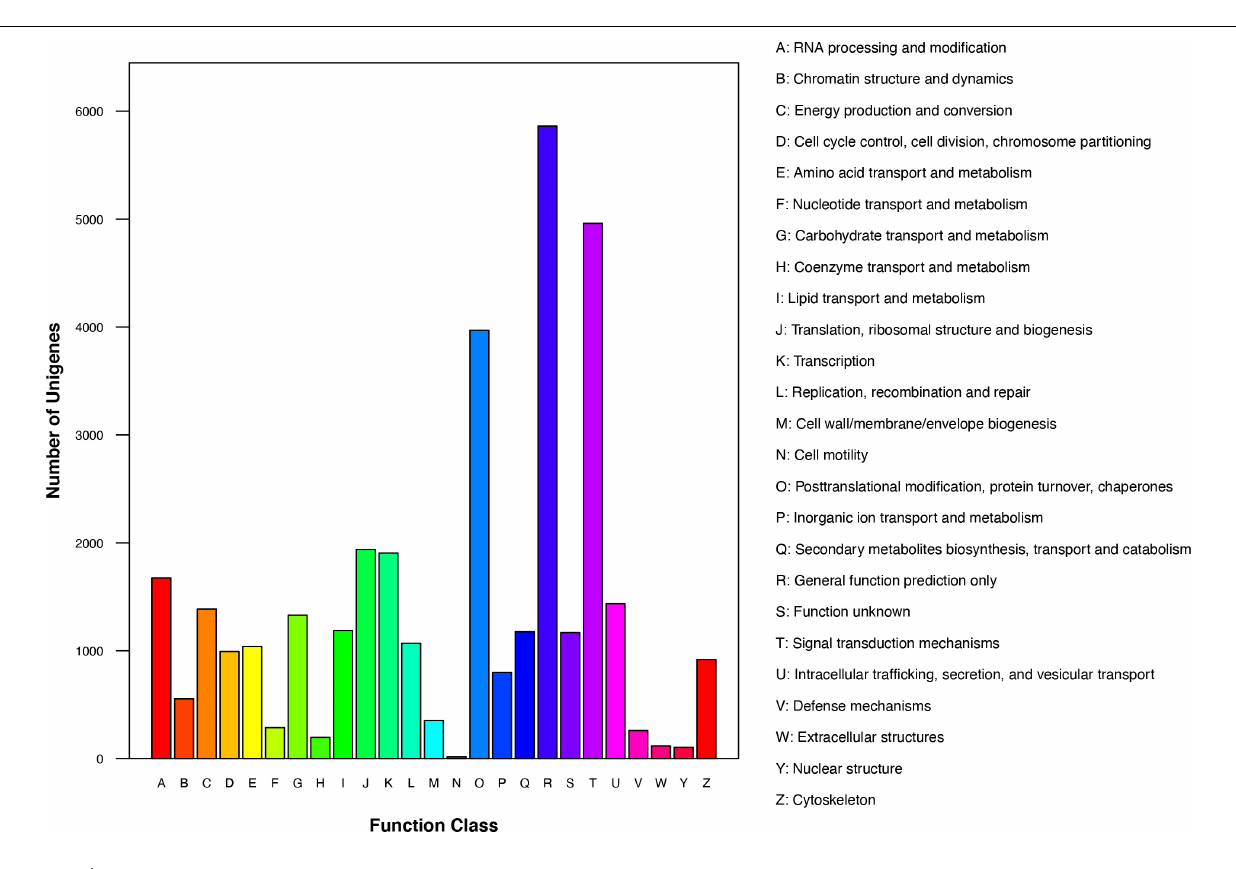
of secondary metabolites” (ko01110), and “Plant–pathogen interaction” (ko04626), which were associated with 649, 374, and 118 DEGs, respectively ( Figure 6C